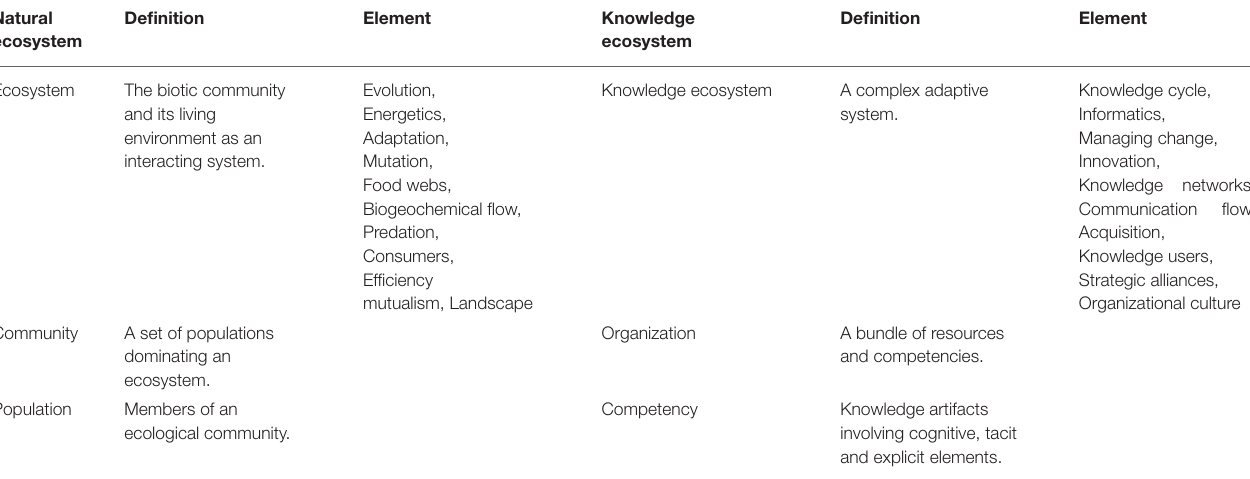
TABLE 5 | Comparison of knowledge ecosystem with natural